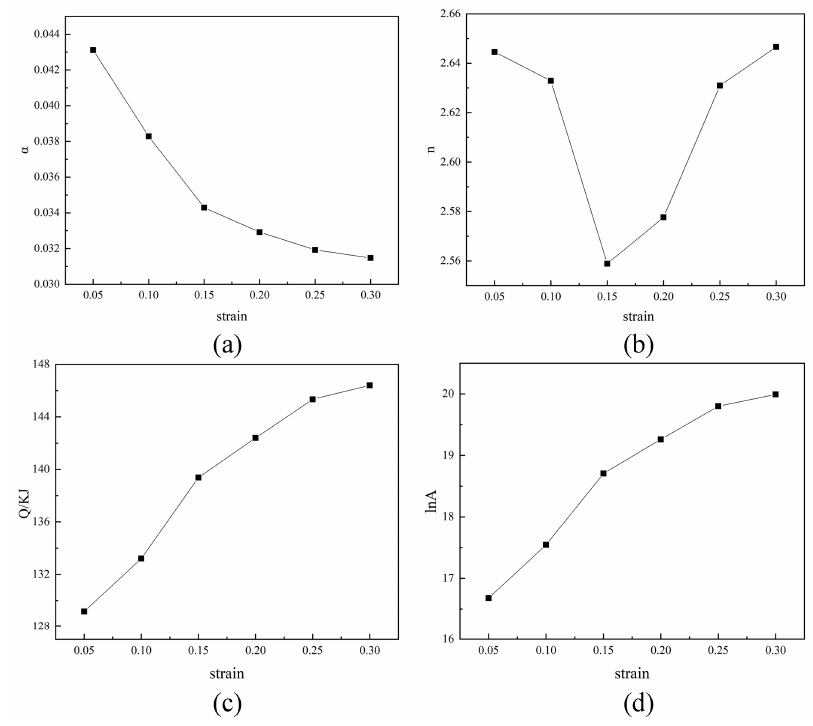
Figure 5. Variation of material constants with strain: ( a ) α ; ( b ) n; ( c ) Q; ( d )